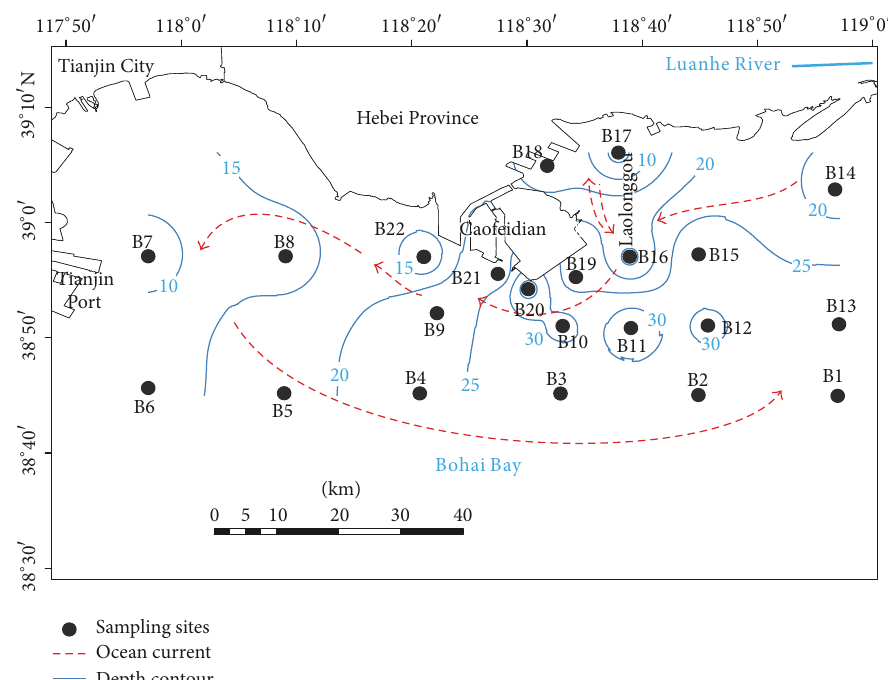
Figure 1: The location of the study area and the sampling sites in the Bohai